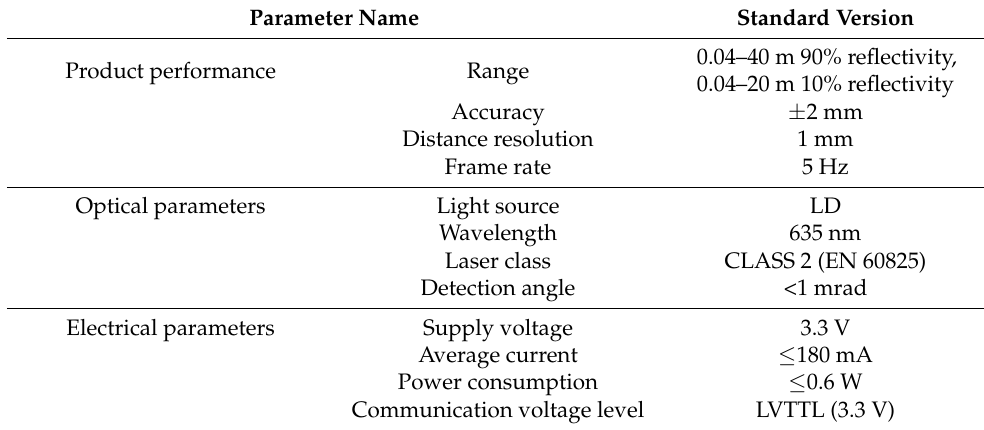
Table 3. Main Parameters of